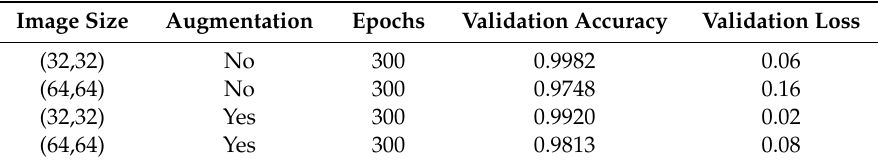
Table 2. Model performances after general